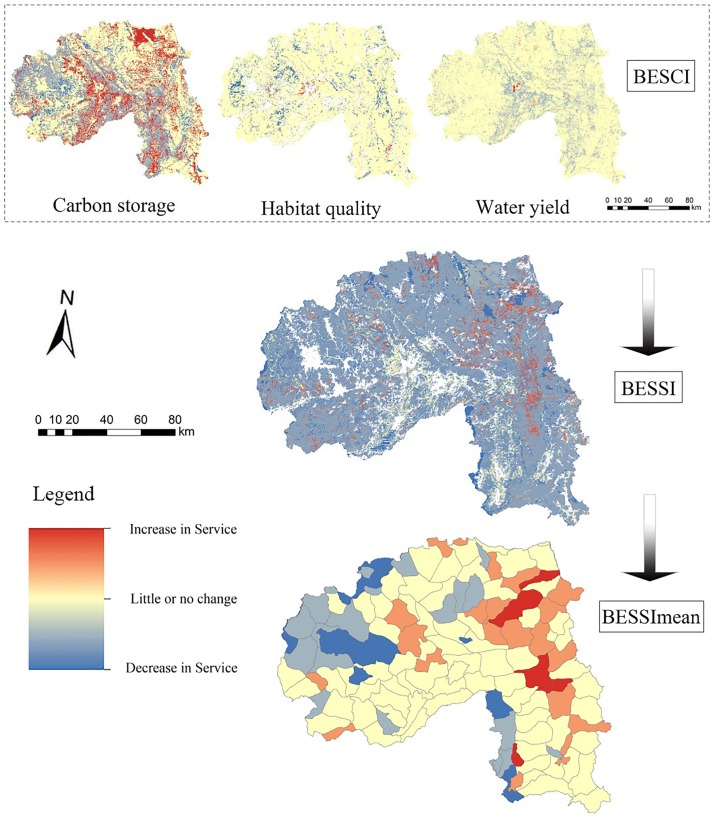
Changes of BES between 1990 and 2010.